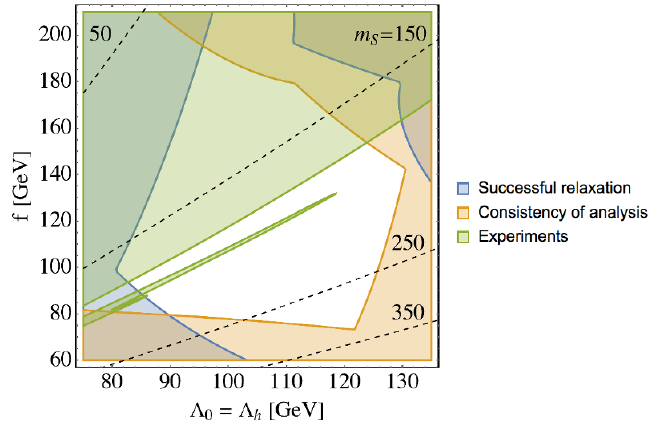
Figure 8 . The experimental constraints. The blue and the orange shaded regions are summaries of (cid:12)gures 5 and 6, respectively. The green region is excluded either by the collider searches at the 95% CL, or by the Higgs signal strength measurements. The black dashed lines indicates m S = 50 ; 150 ; 250 ; 350.